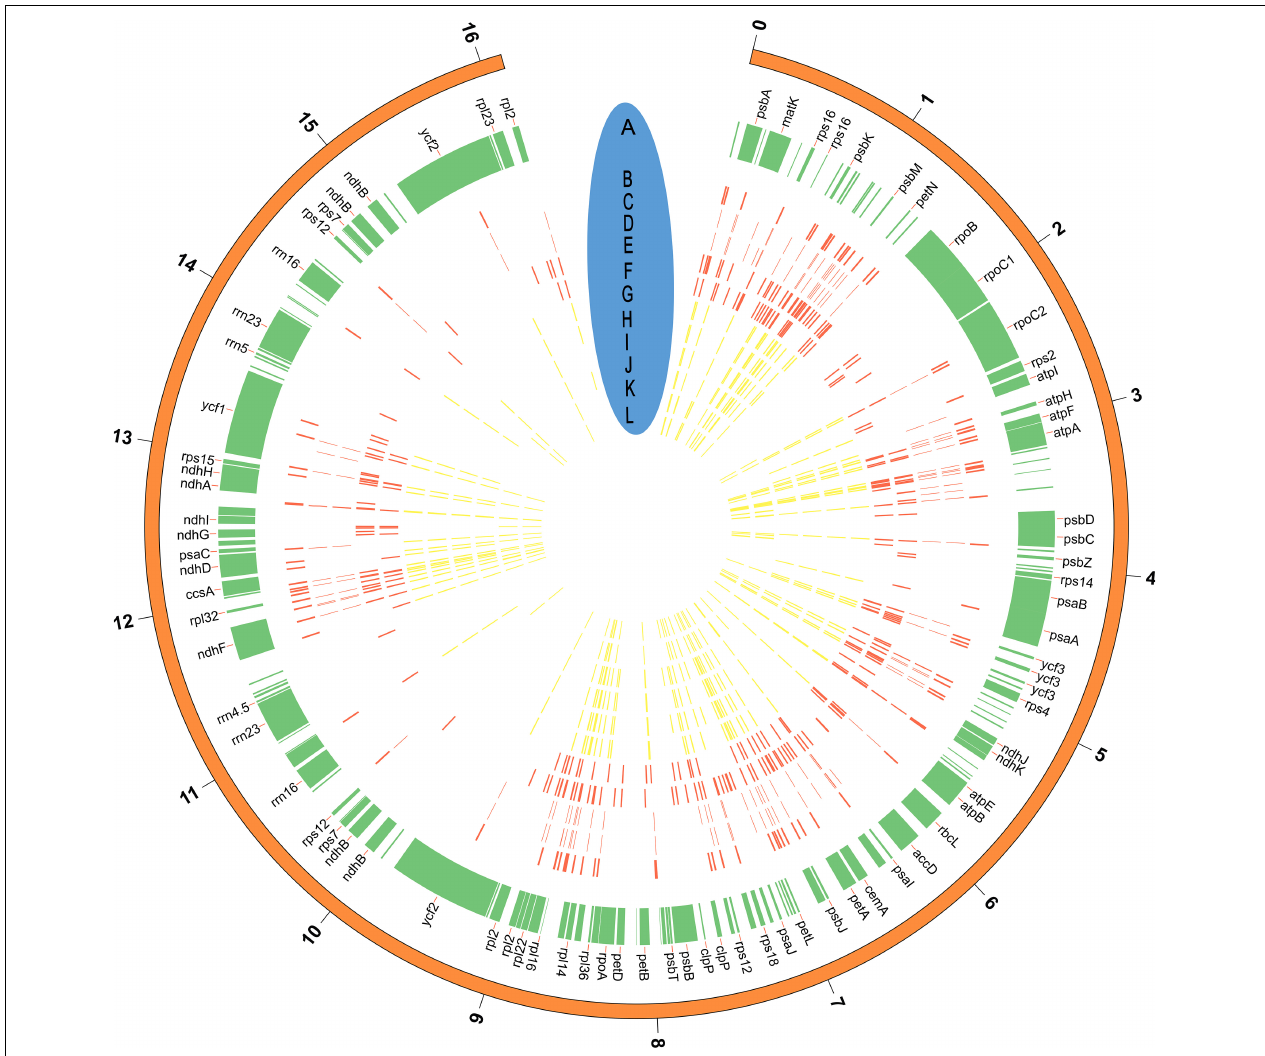
FIGURE 3 | The distribution of genomic variants (SNPs and InDels) across the rubber tree chloroplast genomes. (A) The tag for each gene located in the reference cp genome (67) ( Table 1 ); (B–L) positions of genomic variants identified in the rubber tree cp genomes, representing 68,73,75,78,79,80,84,87,88,89, and 90 ( Table 1 ), respectively. Wild rubber trees are colored in red, while cultivated rubber trees are colored in yellow. The outside distance unit is 10 Kb. Note that not all of cp genes are illustrated in the figure owning to the space